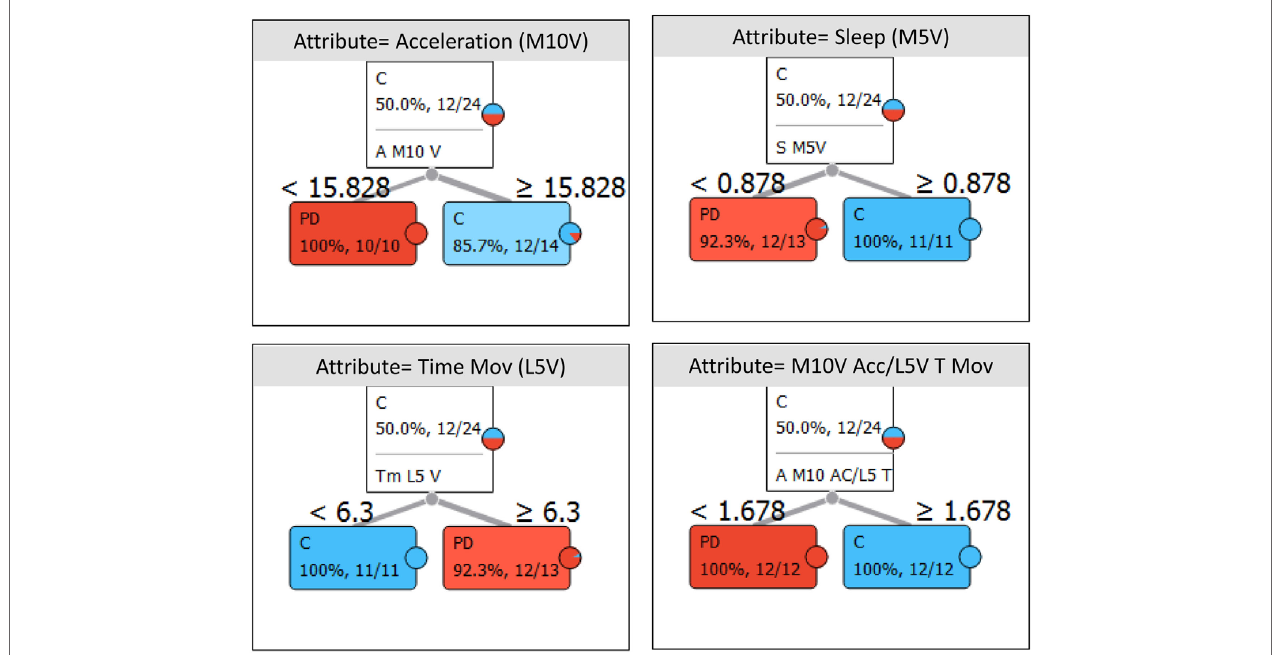
FigUre 5 | Decision trees for Parkinson’s disease (PD) and healthy controls (C) classification, using those attributes selected from the best discriminating variables and the categorical criteria used for its classification. The number of subjects correctly classified as PD (red box) or C (blue box) in showed inside each box, together with the cut-off point is the upper part of the